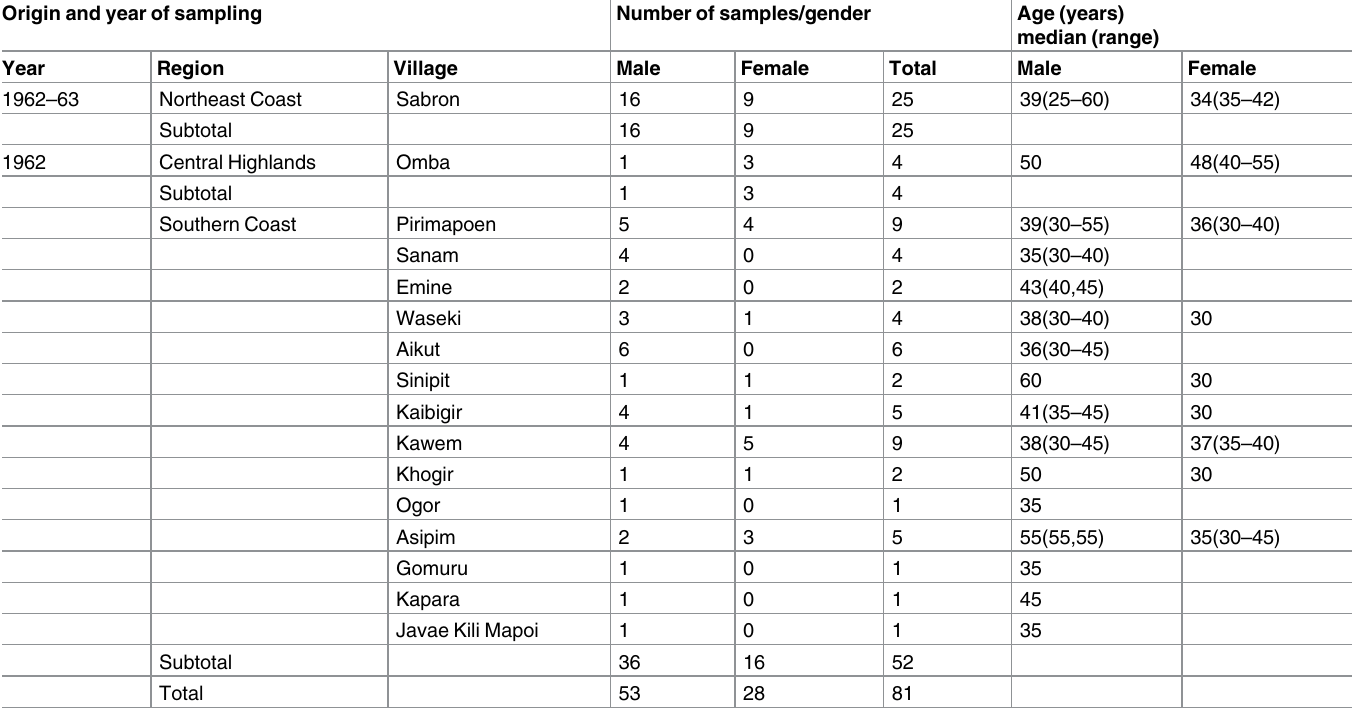
Table 2. Study population, West